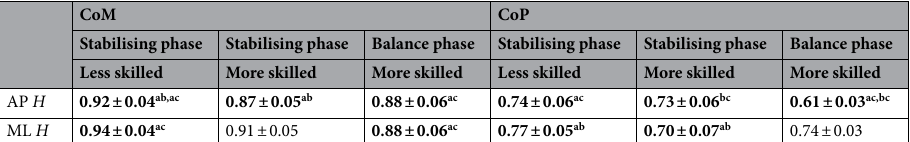
Table 3. Hurst exponent ( H ) outputs for CoM and CoP mean ± S.D. for each group. Bold values indicates a significant difference between two or more conditions ( P < 0.05). ab P < 0.05 between less skilled and more skilled stabilising phase (independent t-test). ac P < 0.05 between less skilled stabilising phase and more skilled balance phase (independent t-test).